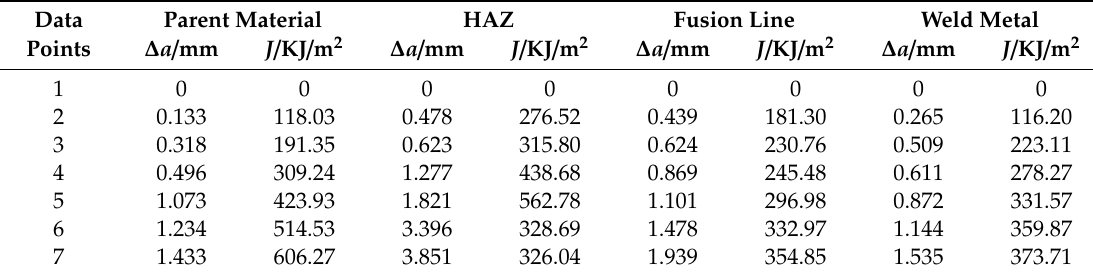
Table 7. Experimental